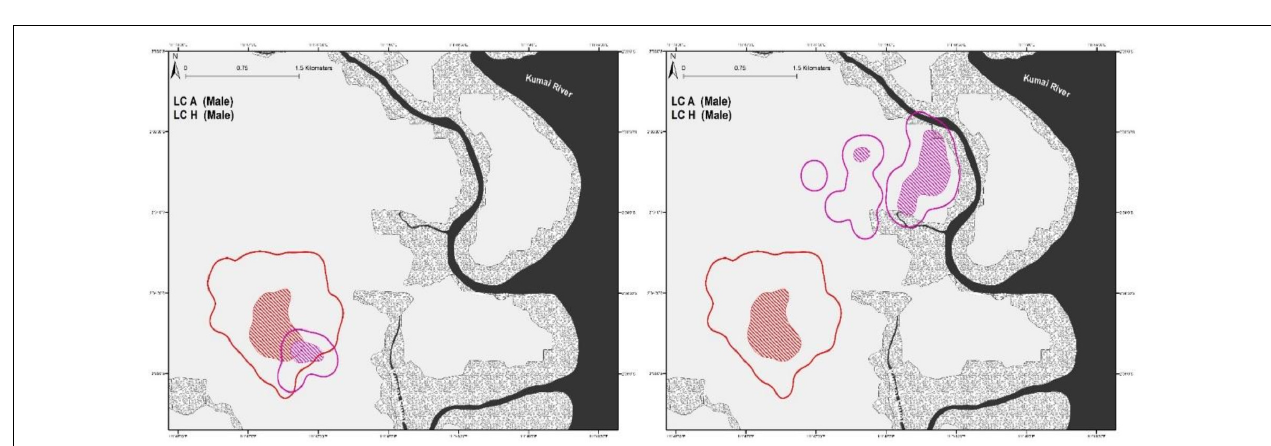
FIGURE 3 | Home-ranges of two male leopard cats, LC-A and LC-H before and after an antagonistic encounter. Considering the small pre-fight home-range size that is almost entirely within LC-A’s home-range, it is likely that LC-H was one of LC-A’s male offspring that was chased out when it began to rival LC-A.